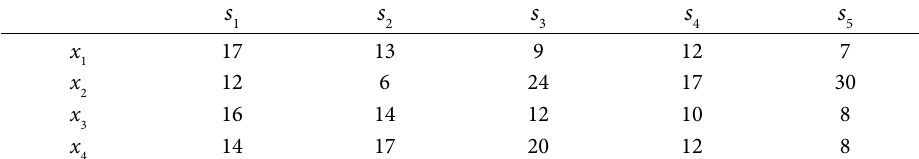
Table 9. Order-inducing variables